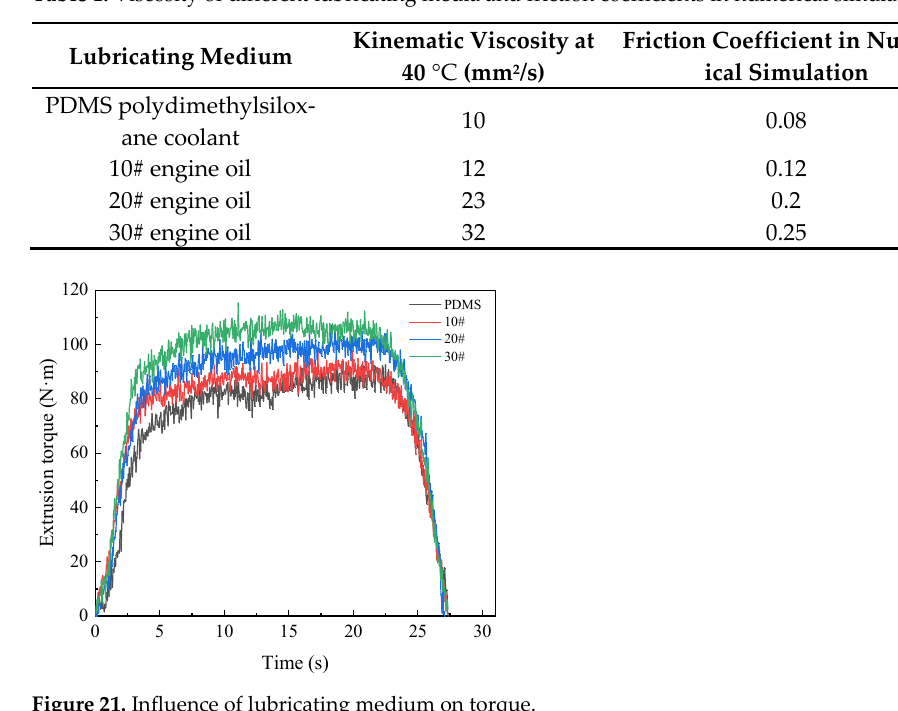
Figure 21. Influence of lubricating medium on torque.